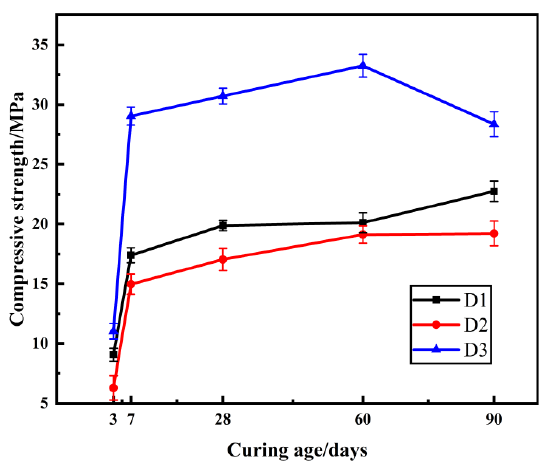
Figure 4. Strength of samples at different curing ages, with different mineral admixtures.